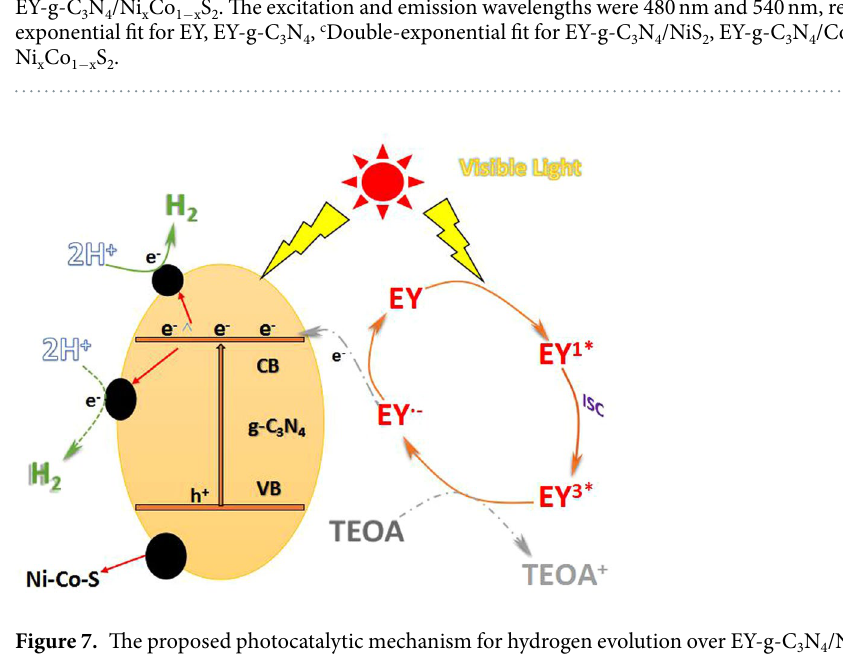
Figure 7. The proposed photocatalytic mechanism for hydrogen evolution over EY-g-C 3 N 4 /Ni x Co 1 − x S 2 photocatalysts under visible light